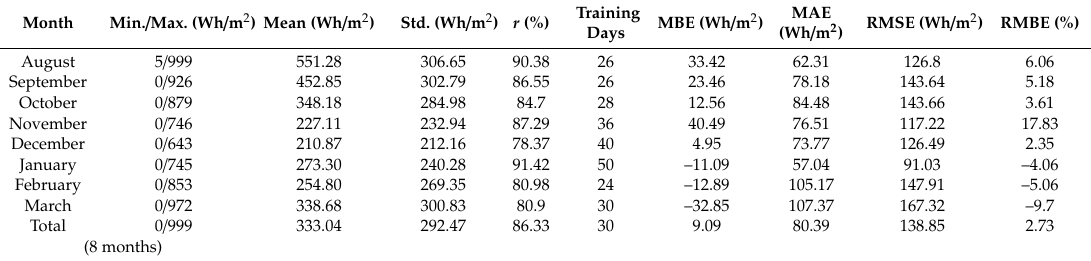
Table 1. Summary of Statistical Values for Actual GHI and Two-Day-Ahead Forecast